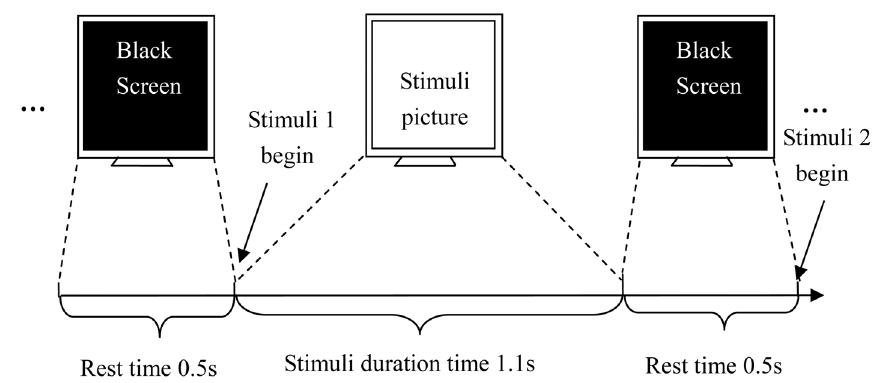
Figure 1. The stimuli sequence diagram.